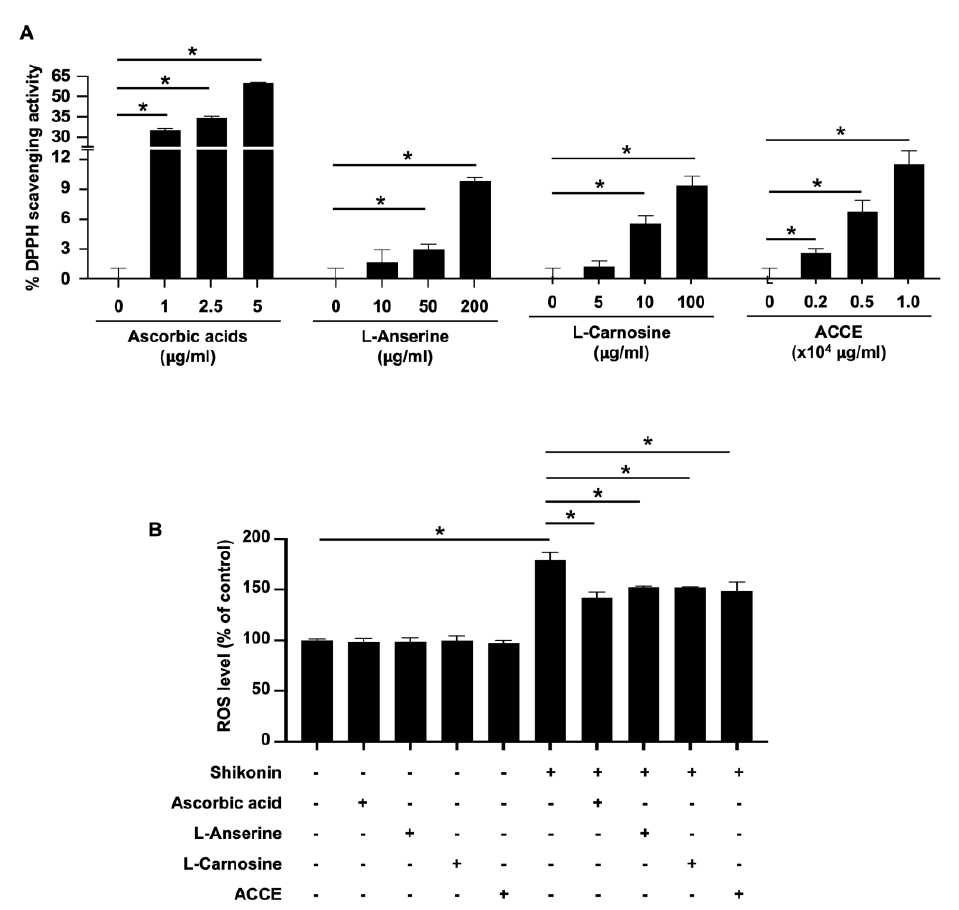
Figure 2. The antioxidant activity of ACCE and its active ingredients, L-anserine and L-carnosine. ( A ) The DPPH scavenging activity of ACCE, L-anserine, and L-carnosine was determined using ascorbic acid as a positive control and methanol diluent as a negative control. ( B ) ROS scavenging activity of ACCE on CCD-986Sk cells was examined using CM-H2DCFDA staining and flow cytometry. Shikonin (was used as the ROS inducer and ascorbic acid was used as a positive control (ROS scavenging agent). Star (*) represents p < 0.05 by Student’s t -test. To investigate the effect of ACCE on tyrosinase activity, the in vitro tyrosinase assay confirmed the inhibitory effect of ACCE, L-anserine, and L-carnosine. Similar to arbutin, a reference tyrosinase inhibitor, L-anserine and L-carnosine significantly suppressed cellular tyrosinase activity to 91.60 ± 4.11% and 91.70 ± 5.27% of control, respectively ( p < 0.05). In addition, ACCE also exhibited anti-tyrosinase activity, demonstrated by the reduction of the cellular tyrosinase activity to 86.93 ± 4.75% of control ( p < 0.05) (Figure 3), while the histidine, equal concentration with L-anserine, and L-carnosine (1 mM), did not show a significant effect on tyrosinase